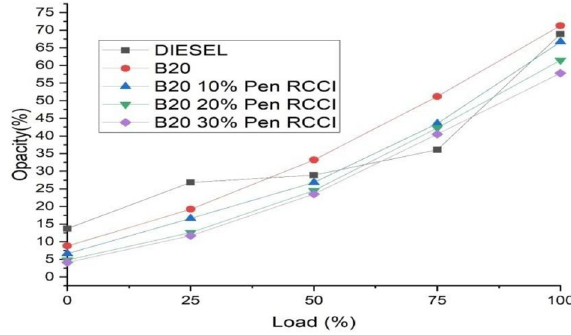
Figure 12. Smoke opacity versus